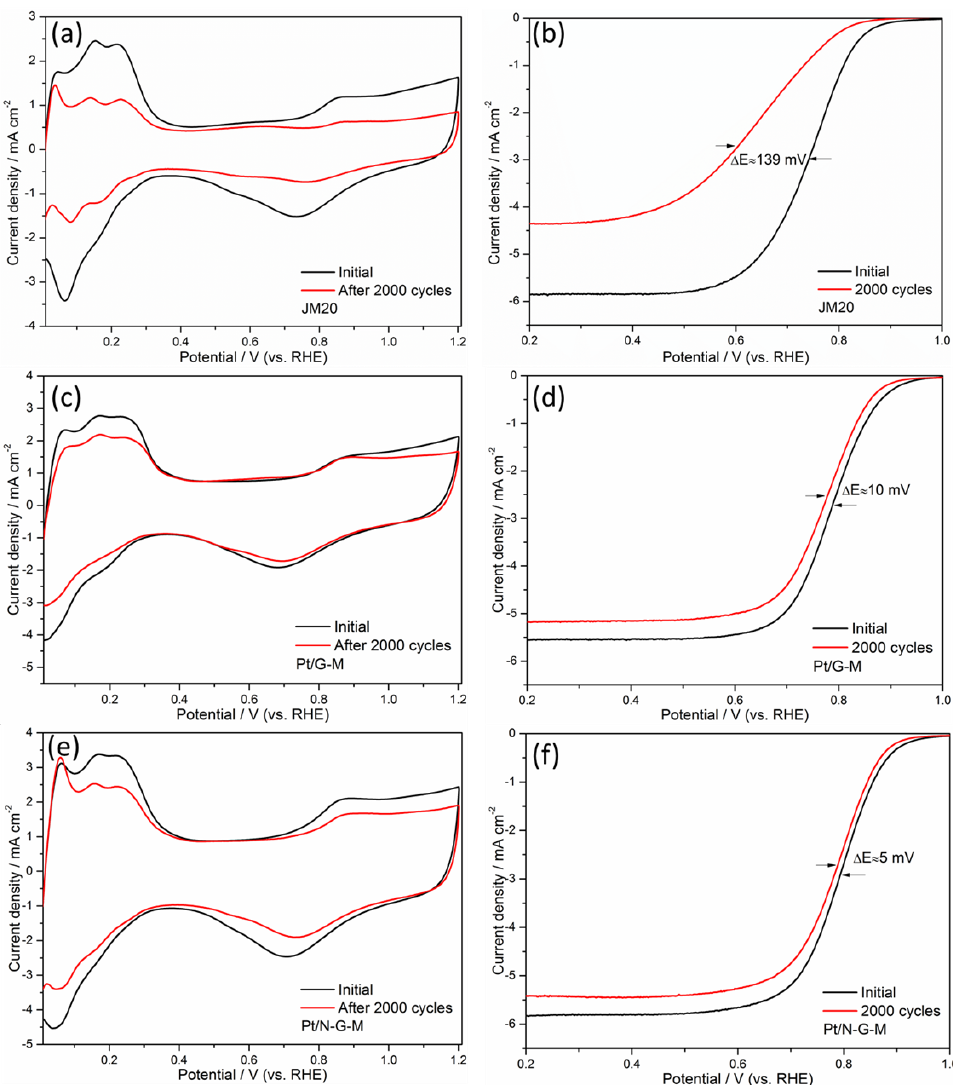
Figure 7. CV curves of ( a ) JM20, ( c ) Pt/G-M, and ( e ) Pt/N-G-M before and after ADT, CV recorded at a scan rate of 100 mV·s −1 in 0.1 M HClO 4 . LSV curves for ( b ) JM20, ( d ) Pt/G-M, and ( f ) Pt/N-G-M before and after ADT, LSV recorded at a scan rate of 5 mV·s −1 in 0.1 M HClO 4 .